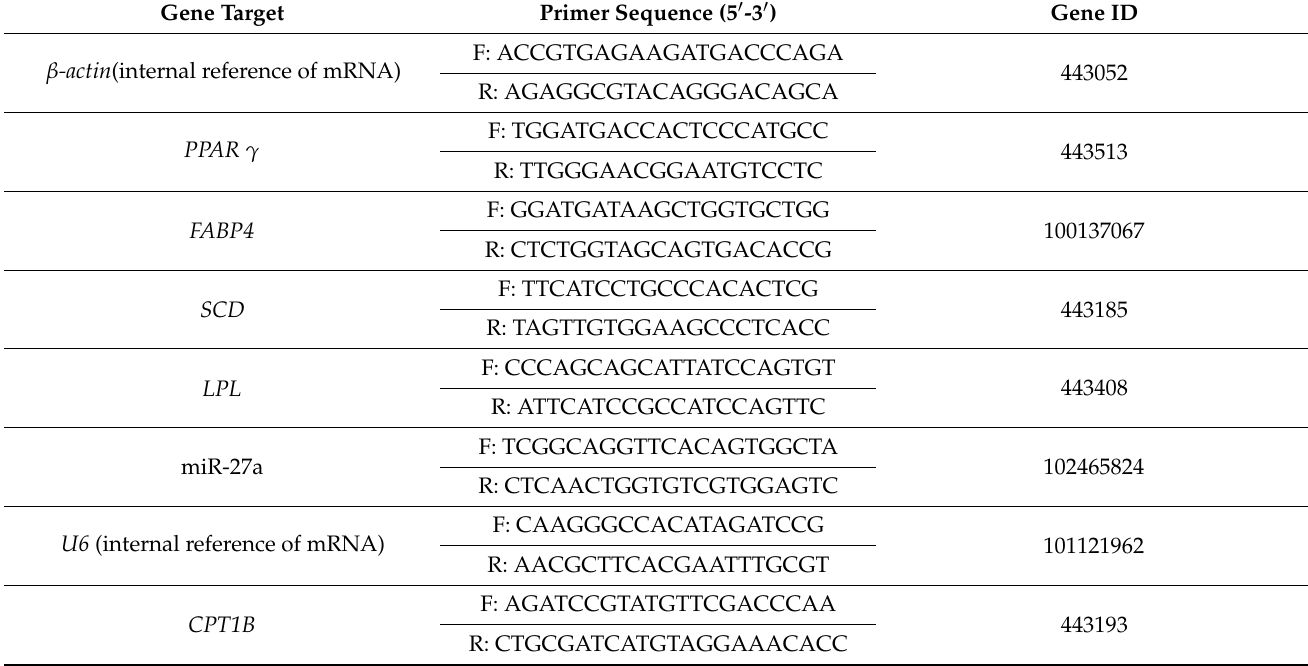
Table 1. The sequence of primers used in the study for mRNA and miRNA quantitative real-time PCR. Gene Target Primer Sequence (5 (cid:48) -3 (cid:48) ) Gene